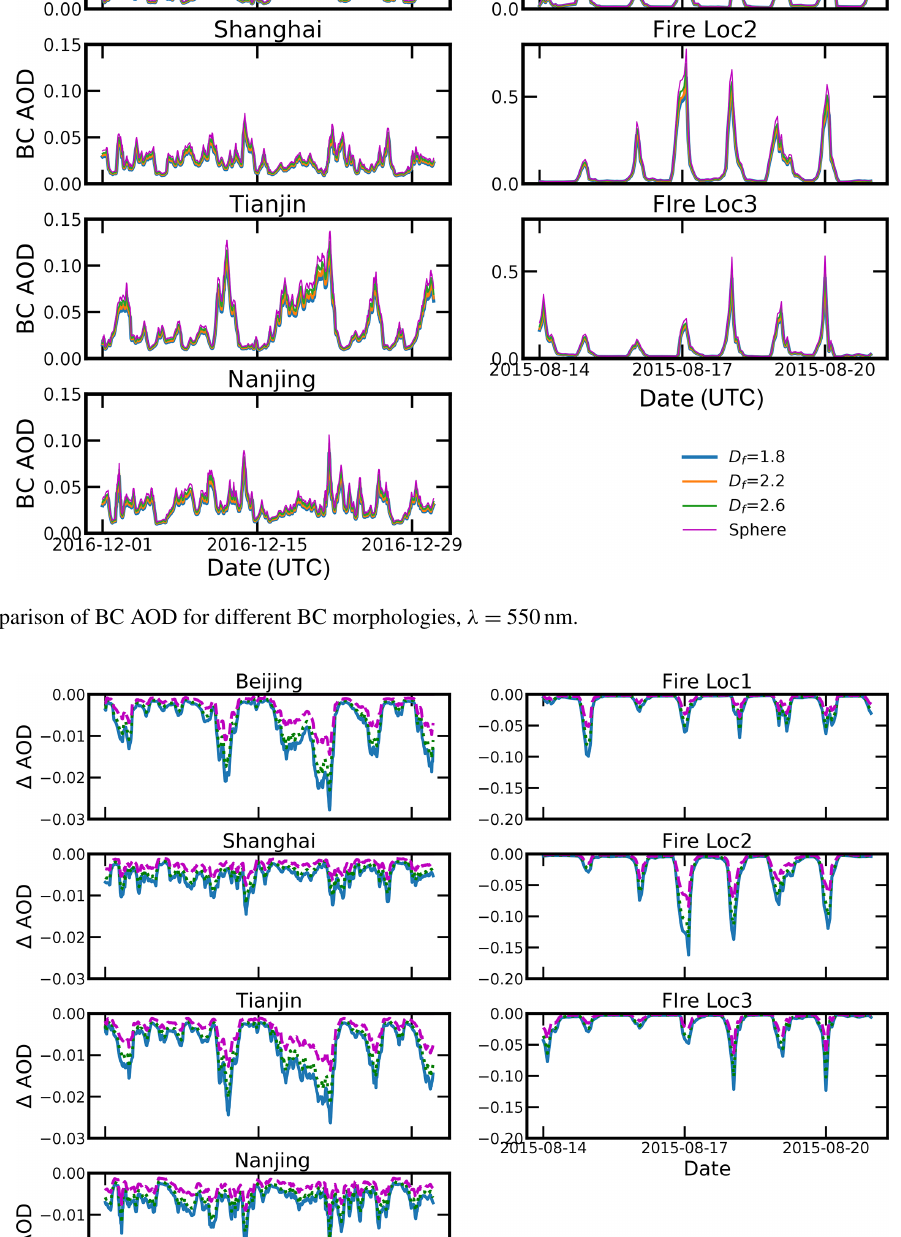
Atmos. Chem. Phys., 22, 7647–7666, 2022